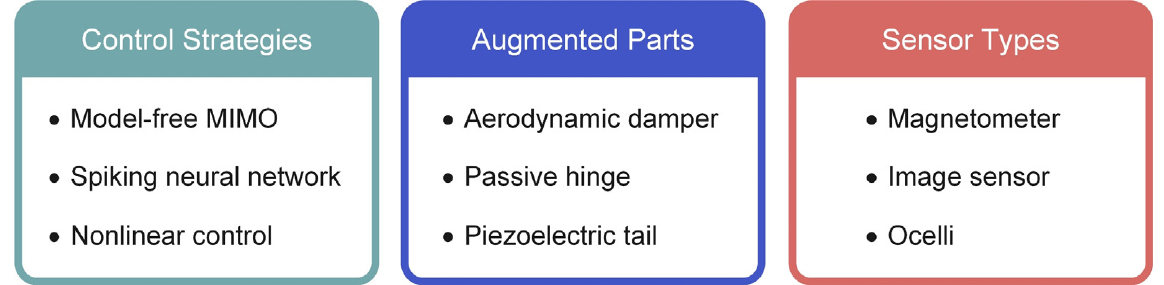
Figure 10. Overview of the technologies used in the control section.